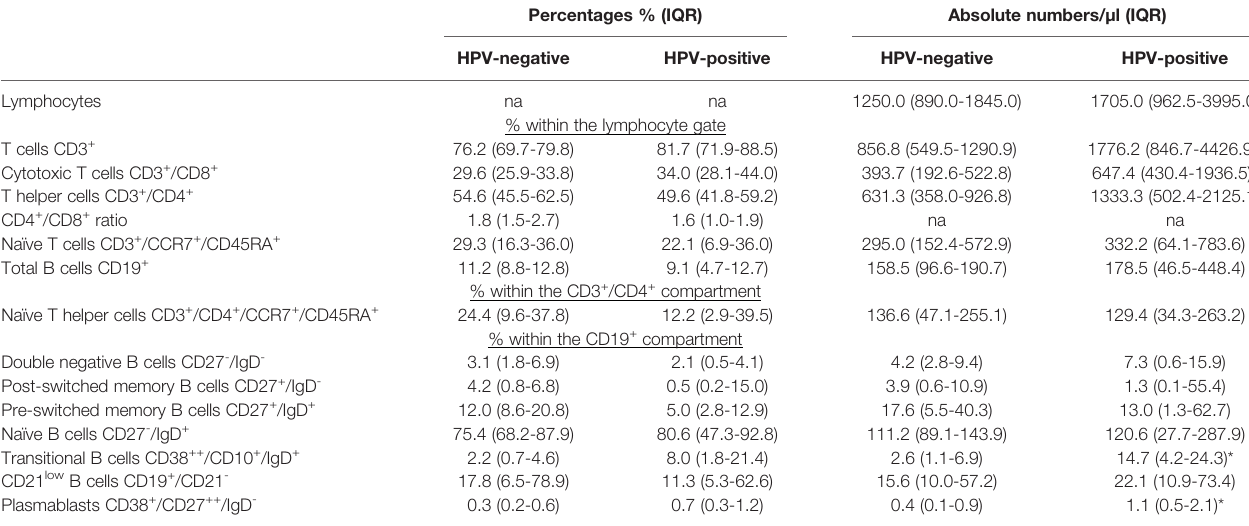
TABLE 3 | Lymphocyte subsets of PID patients comparing those with a genital HPV infection versus those without a HPV